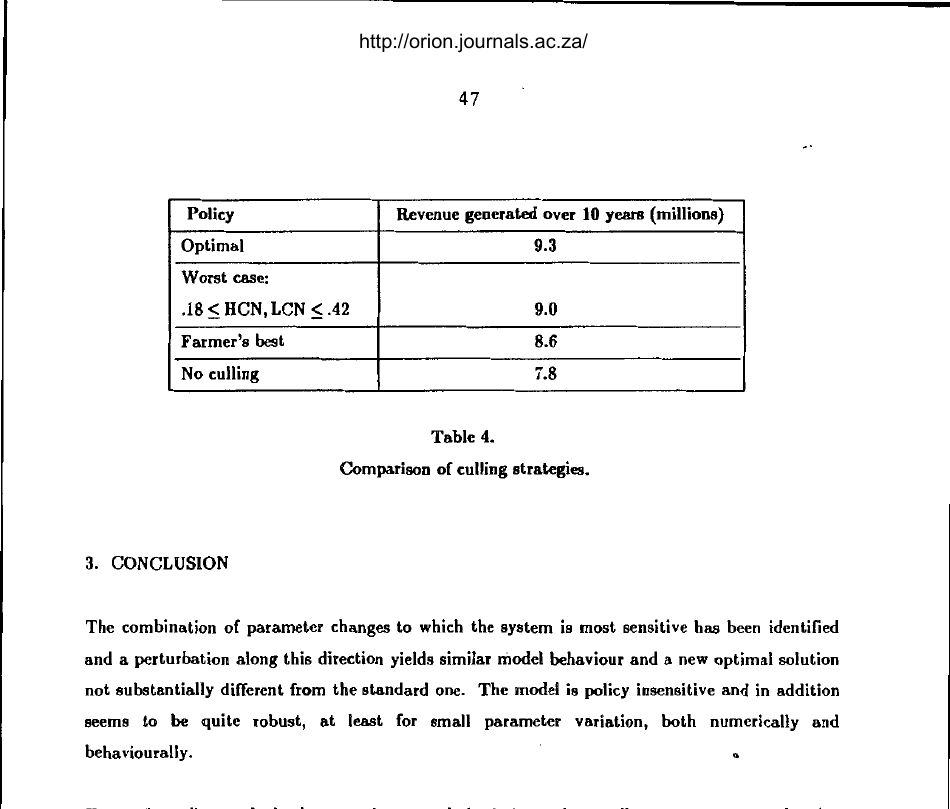
Comparison of culling